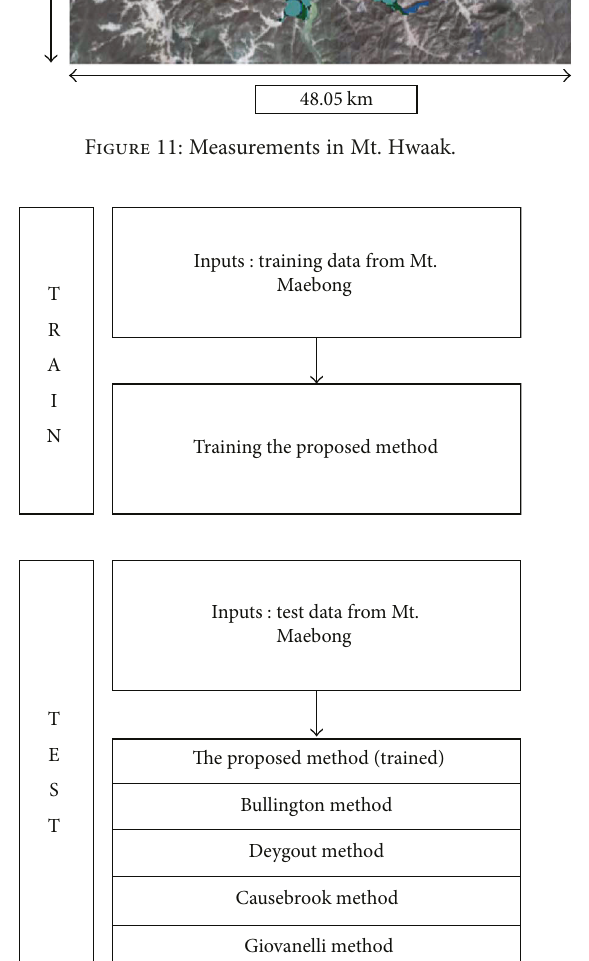
Figure 12: Scenario 1 (in Mt. Maebong).